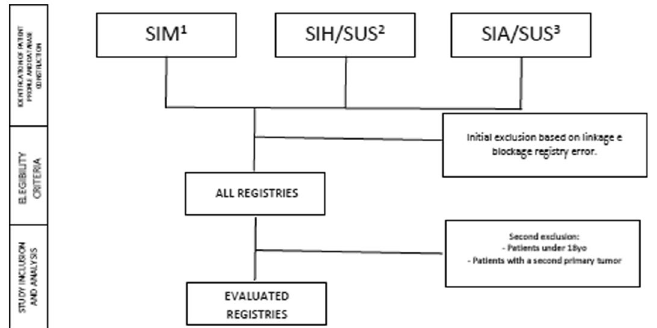
Figure 5. Study design. 1 Mortality Information Systems (SIM), 2 Outpatient Information System (SIA/SUS), 3 Hospital Information System